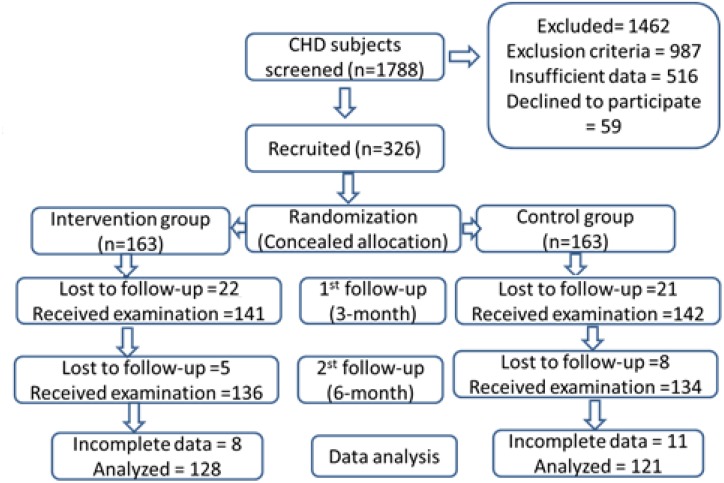
Study flow diagram.